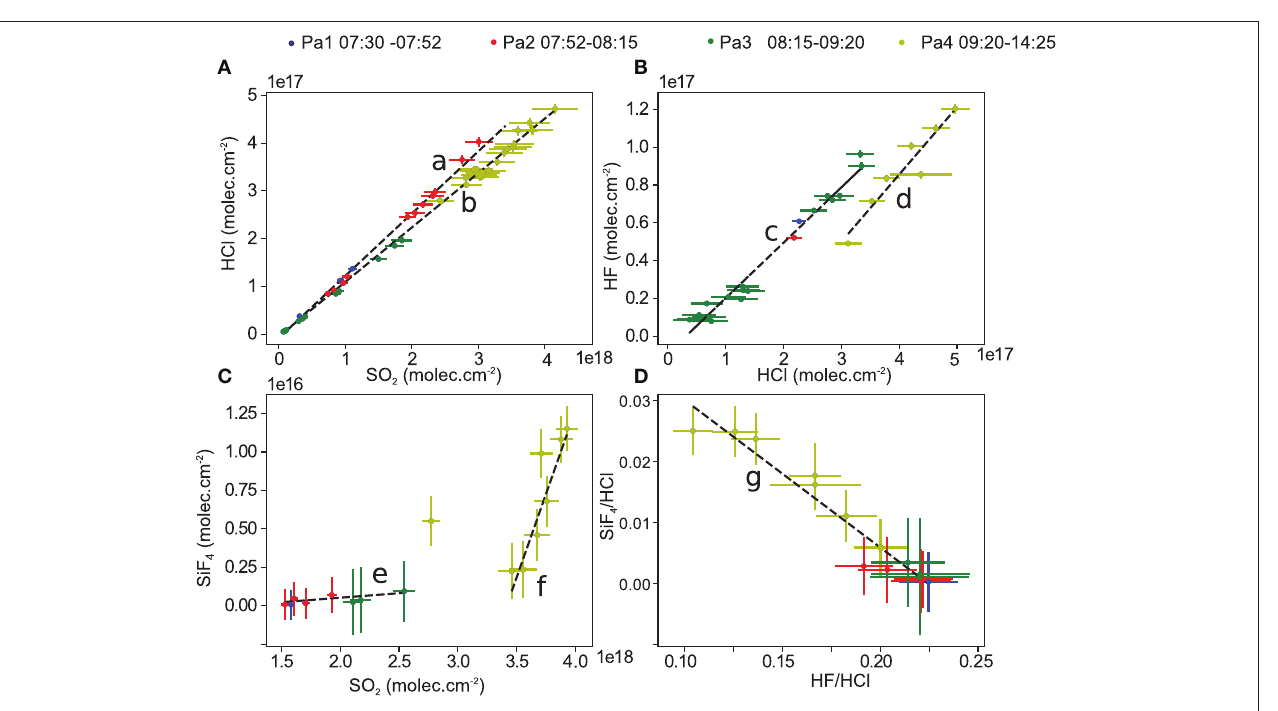
FIGURE 6 | Correlation plots of (A) HCl vs. SO 2 , (B) HF vs. HCl, (C) SiF 4 vs. SO 2 , and (D) SiF 4 /HCl vs. HF/HCl several minutes preceding, during and several hours after the detection of an explosion occurring on March 6th, 2015 at 07:30 a.m. The different colors correspond to the periods mentioned in Figure 5